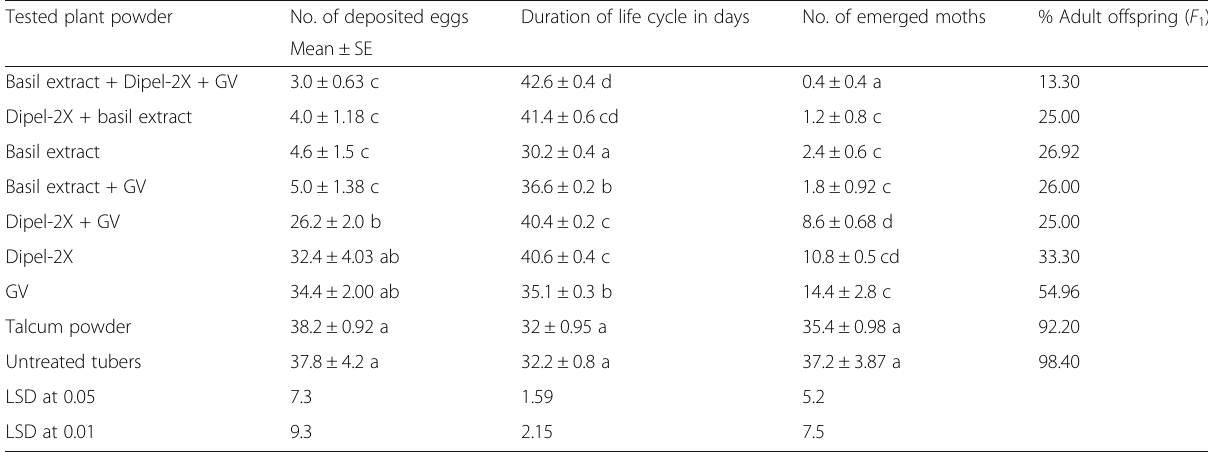
Means with the same letters are not significantly different in vertical column, P